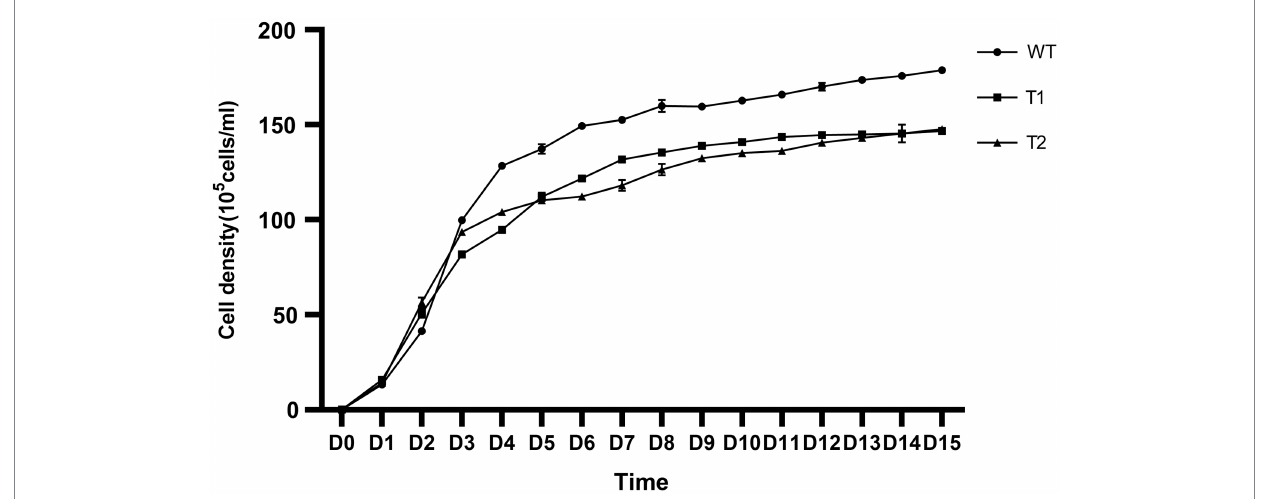
FIGURE 9 Growth curve of wild type and transformants from inoculation to the 15th day. The ordinate is the cell density.